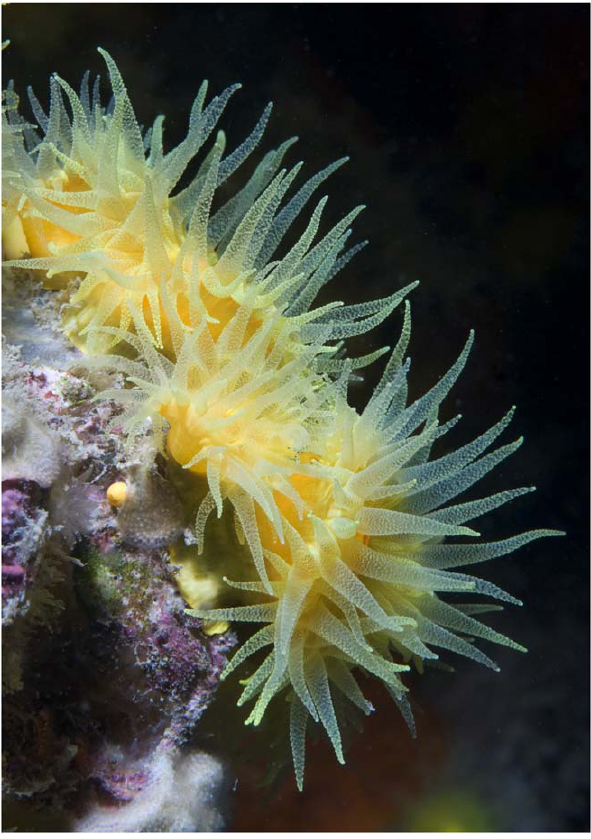
Figure 1. Living specimens of Leptopsammia pruvoti in an overhang on the Italian